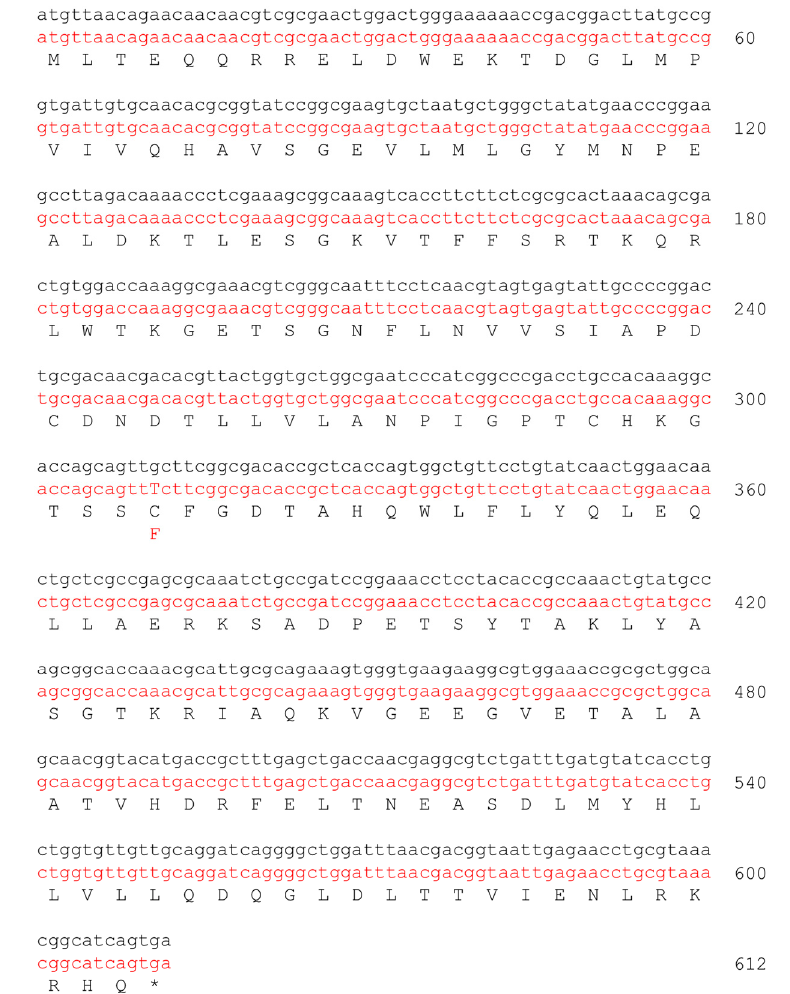
Figure 5. Nucleotide sequence of the hisIE gene from E. coli wild-type (black) and the mutant strain E. coli FB181 (red). The amino acid sequence of the encoded protein is reported in upper case. Asterisk indicates the stop codon in E. coli hisIE sequence.